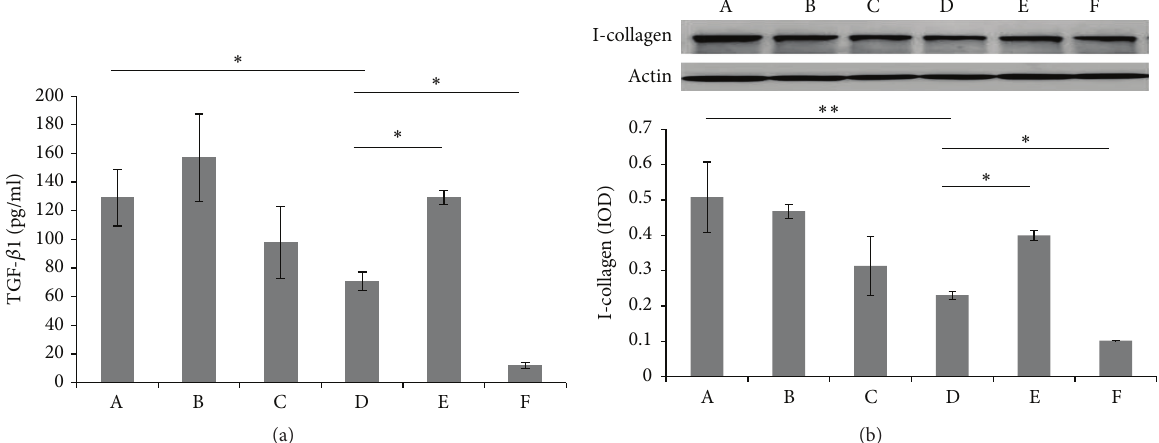
Figure 5: The expression of TGF- 𝛽 1 and type I collagen in guinea pig scleral fibroblasts. (a) ELISA for the expression of TGF- 𝛽 1 in supernatant of guinea pig scleral fibroblasts. (b) Western blot for the expression of type I collagen in scleral fibroblasts. (A) SC, (B) SC + DKK-1, (C) SC + TGF- 𝛽 1 neutralizing antibody, (D) FDM, and (E) FDM + DKK-1. (F) FDM + TGF- 𝛽 1 neutralizing antibody ( ∗ 𝑃 < 0.05 , ∗∗ 𝑃 < 0.01